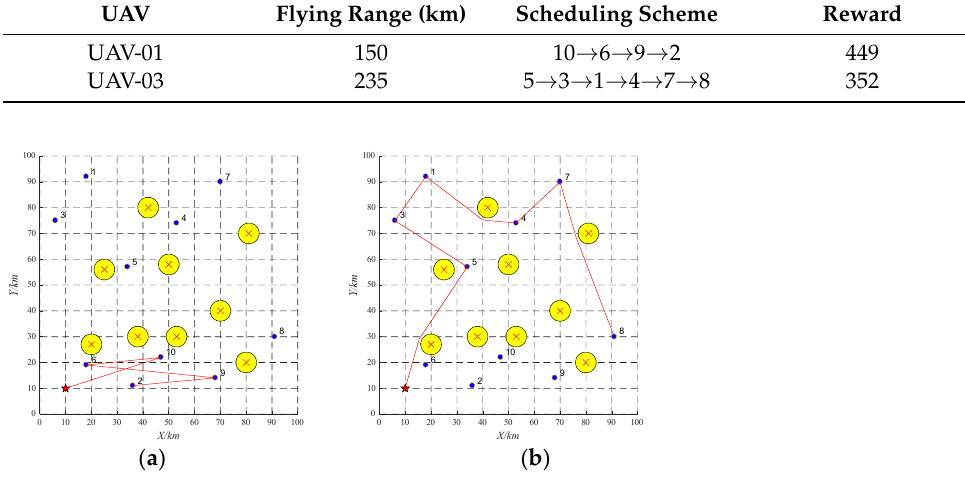
Figure 12. Task re-scheduling schemes with the platform failure based on hybrid contracts. ( a ) UAV-01; ( b ) UAV-03.